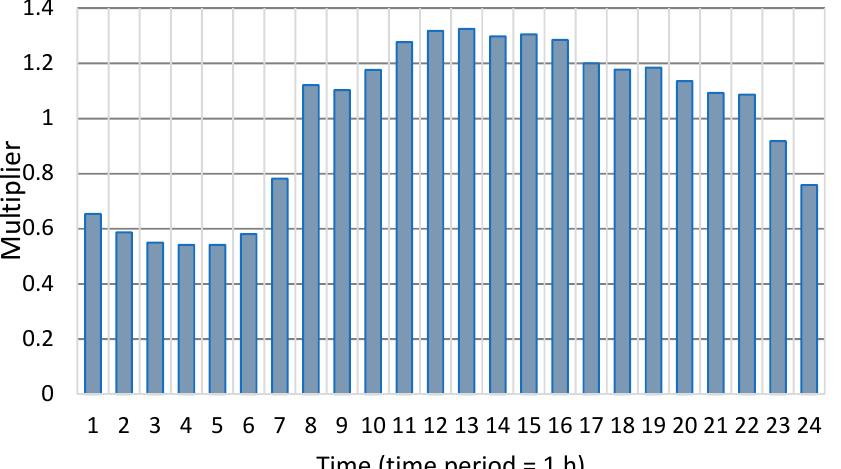
Figure 5. Demand pattern for the Curicó network. Table 1. Electricity for the case study